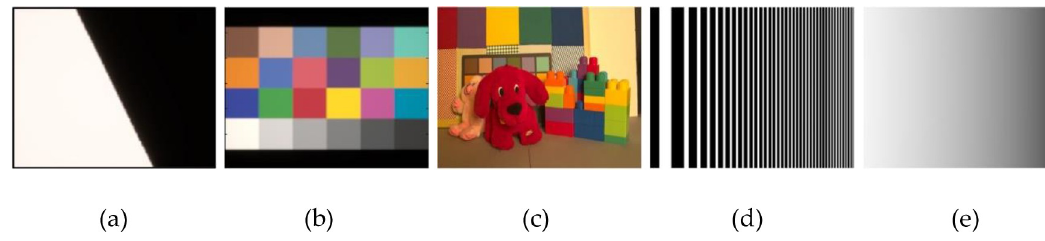
Fig 3. Test input images used in the proposed CFA IQ evaluation system: (a) SLANTED-BAR, (b) MCC, (c) PUPPY, (d) LINEAR-CHIRP, and (e)